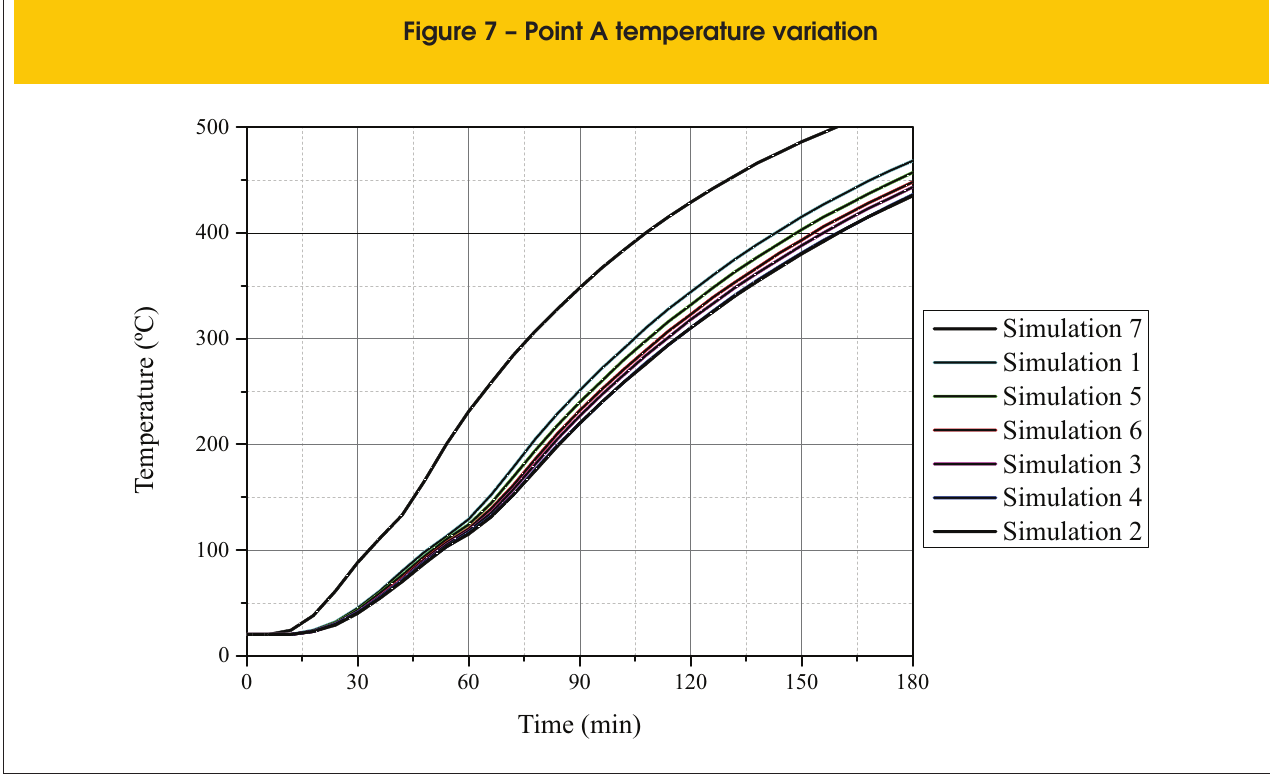
Figure 7 – Point A temperature variation